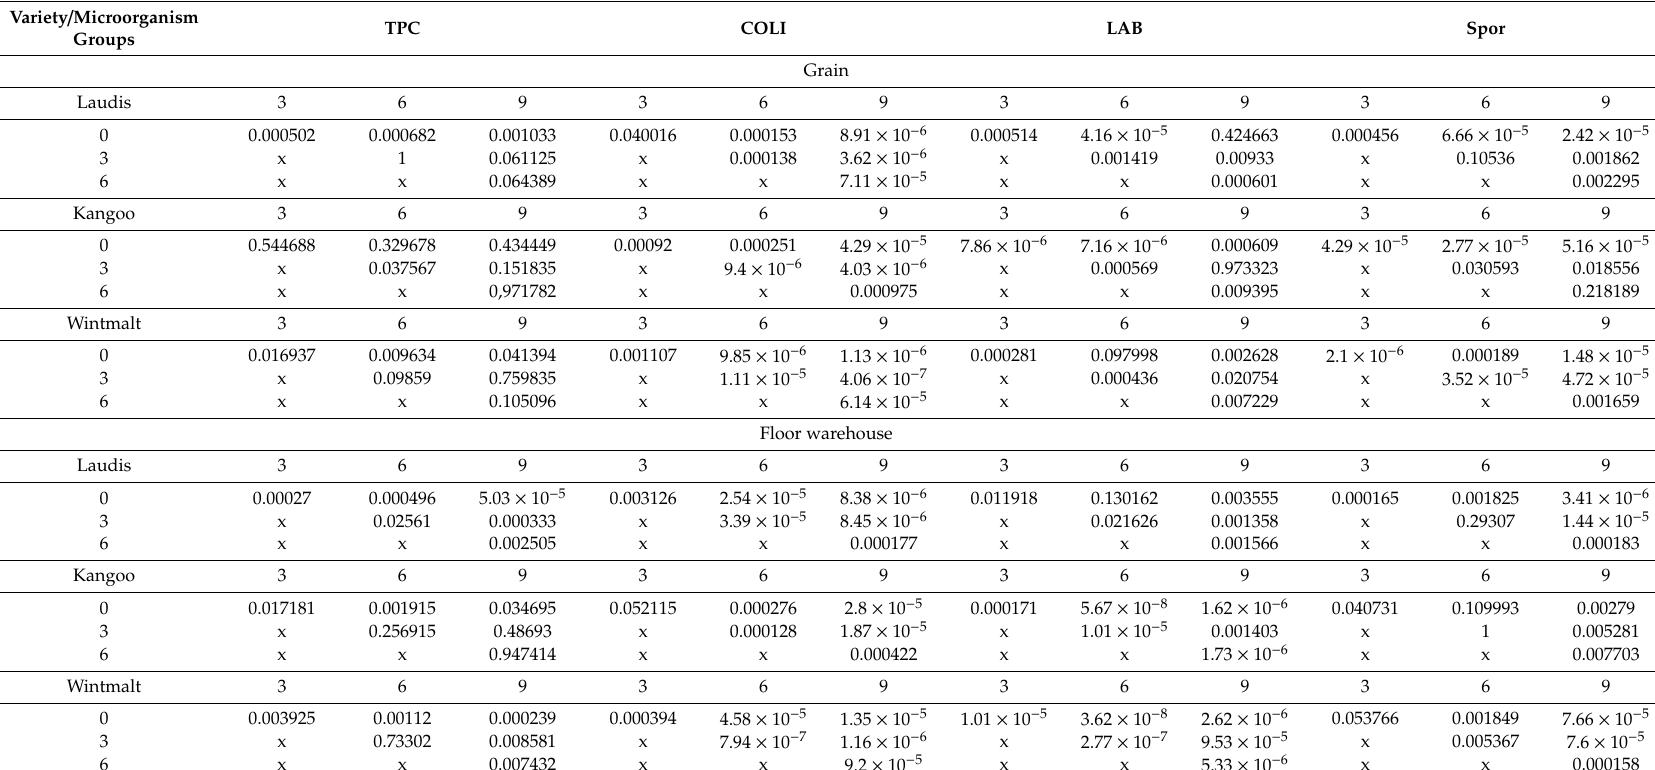
Table 7. p -values among analyzed malt depending on the time and type of storage of the three varieties of barley ( p < 0.05). Variety / Microorganism